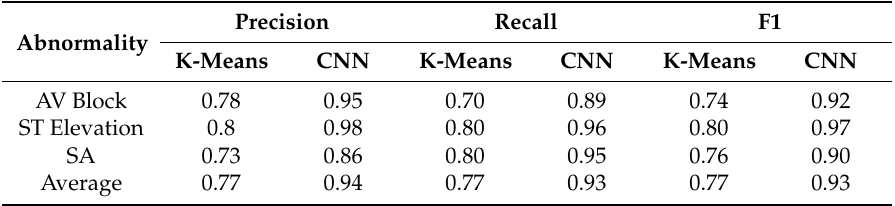
Figure 9. ( a ) The confusion matrix for k-means clustering-based classification; ( b ) The confusion matrix for CNN-based classification. Table 2. Classifier results.